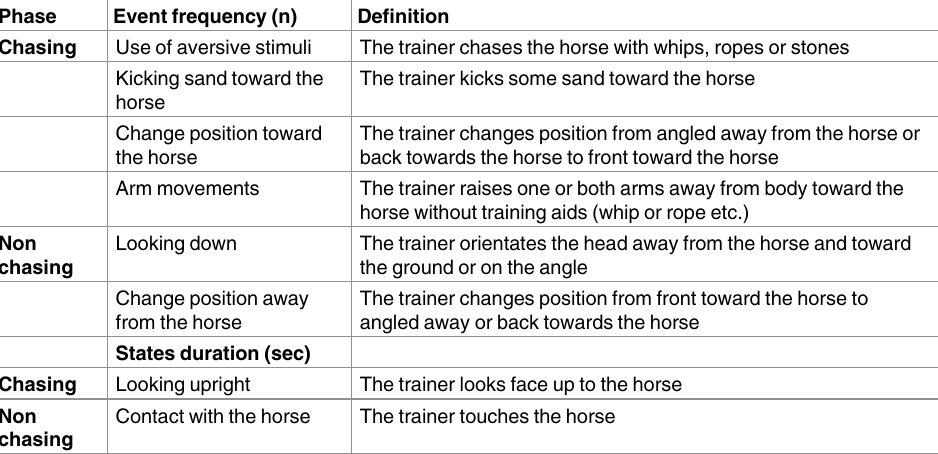
Table 2. Ethogram of selectedtrainer behaviours and states.